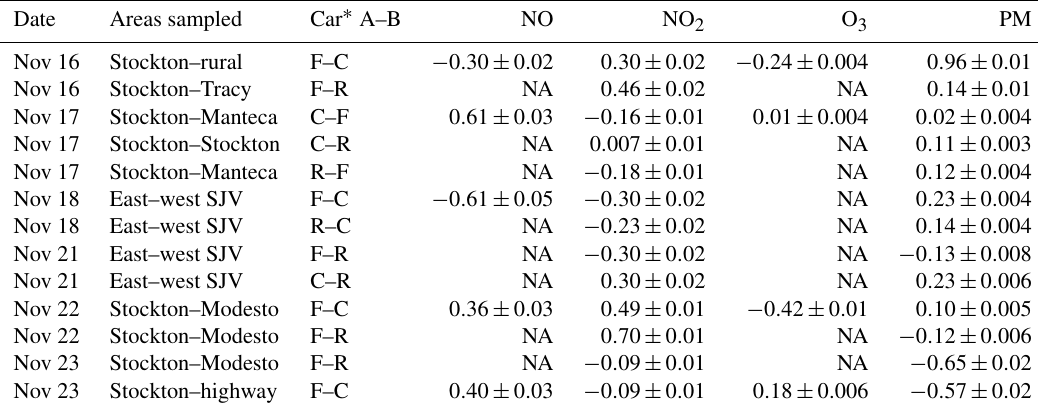
Table 12. Fractional mean differences (FMDs) when vehicle pairs sampled different areas within the northern San Joaquin Valley. Vehicles A and B correspond to the first and second areas sampled, respectively. Uncertainties are 1 standard error of the means. NA is not available; one car (Rhodes – R) measured only NO 2 and PM